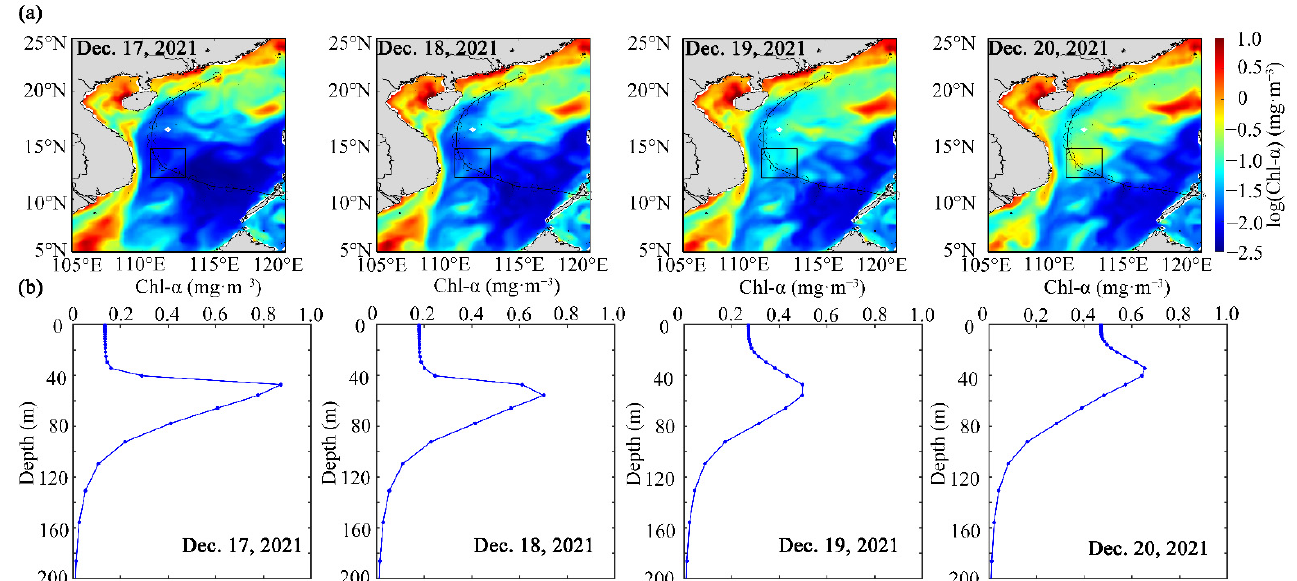
Figure 6. Chl- a changes before and after the passage of STY “Rai”. ( a ) Horizontal distribution of surface Chl- a . ( b ) Vertical profiles of the regional average of Chl- a in the black box of the study area. Before the passing of STY (17–18 December 2021), after the passing of STY (19–20 December 2021). The black hollow circle represented the location of the STY every 6 h, and the black line represented the path of the